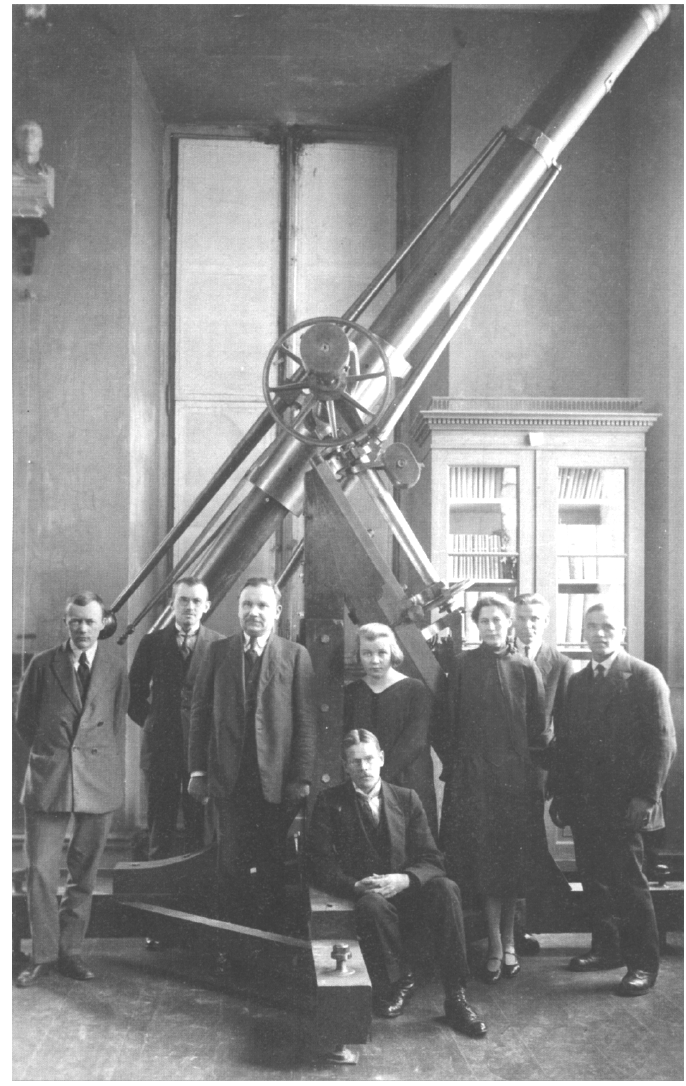
Fig. 3. Ernst ¨Opik (leftmost person) with Tartu Observatory employees at the Fraun- hofer refractor. The lady in the middle is Alide, ¨Opik’s wife. Source: Leppik